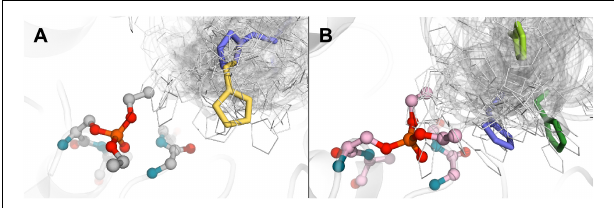
FIGURE 2 | Positions of histidine residue selected after calculation and clusterization of structures corresponding to the clone 14 (A) and clone 15 (B) .